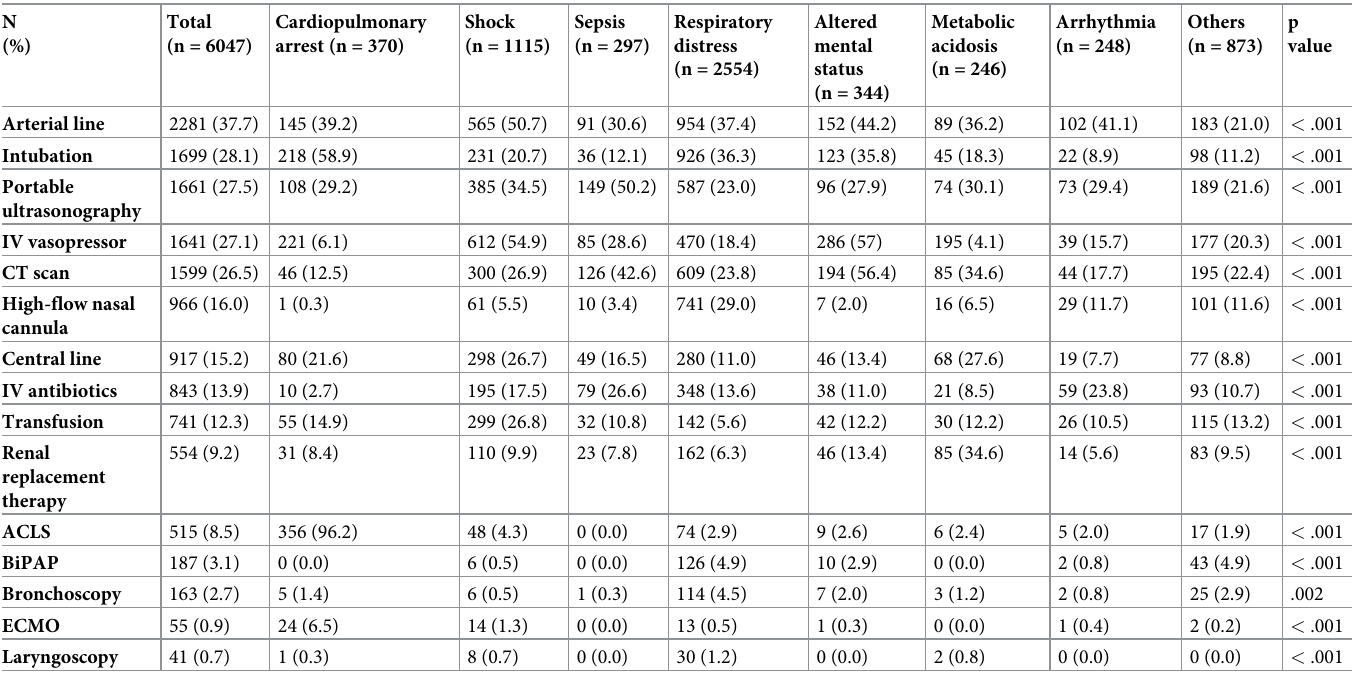
Table 4. Medical emergency team intervention rates according to the activation